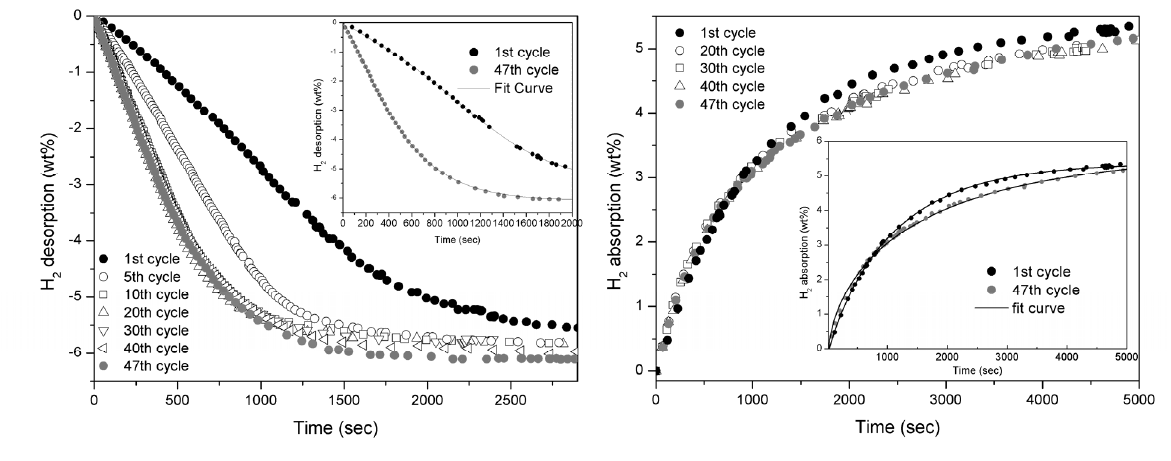
Figure 2. Desorption ( left ) and absorption ( right ) curves of MgH Fe taken at 300 °C and 0.2 bar for desorption and 10 bar for absorption.